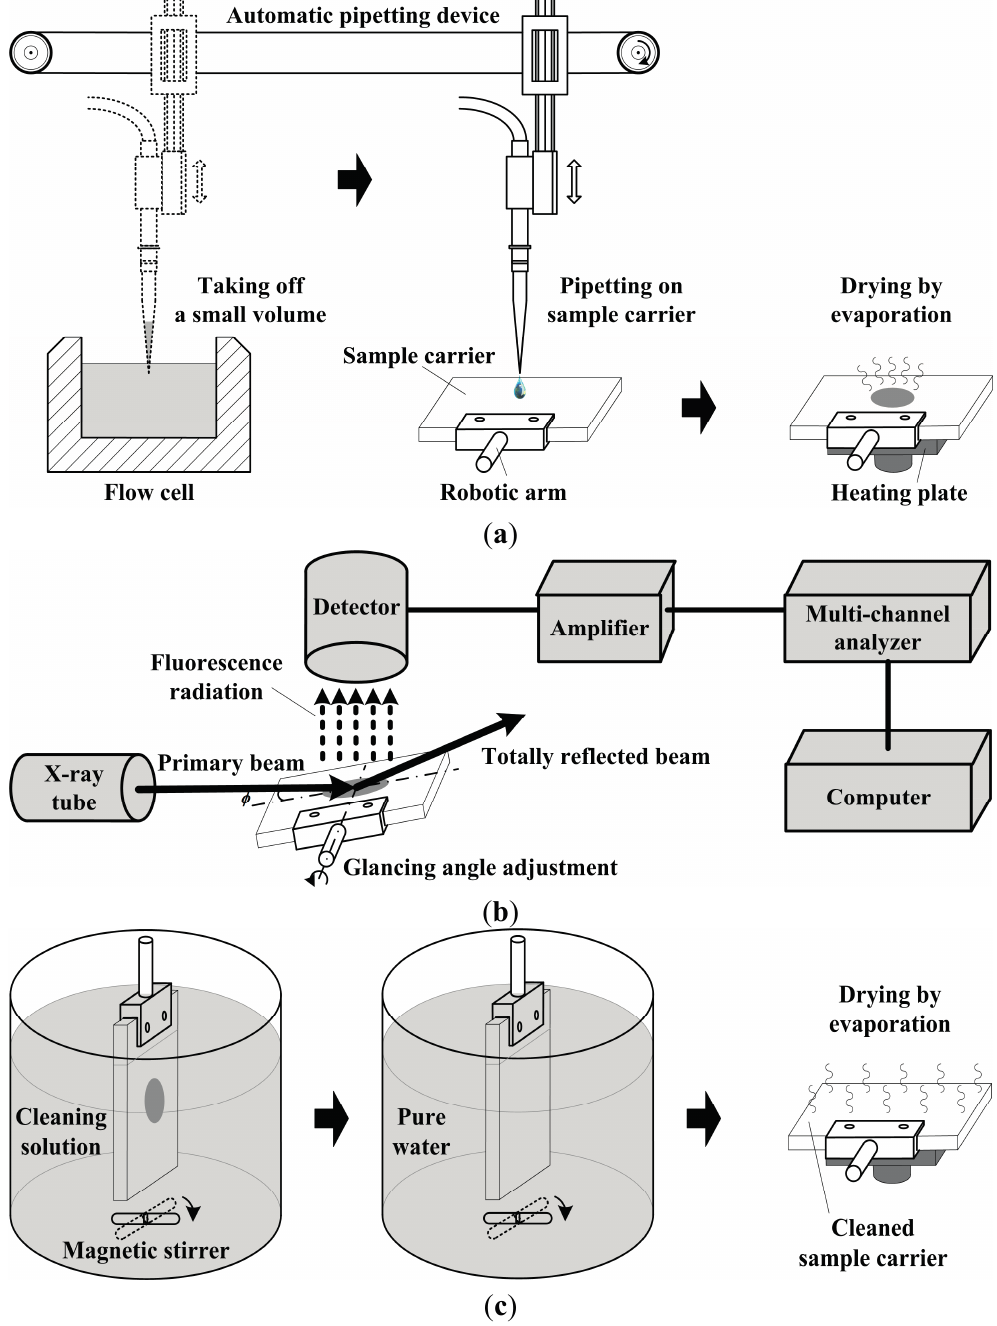
Figure 1. Operation procedure of the online TXRF analysis platform. ( a ) Sample preparation; ( b ) TXRF measurement; ( c ) Carrier